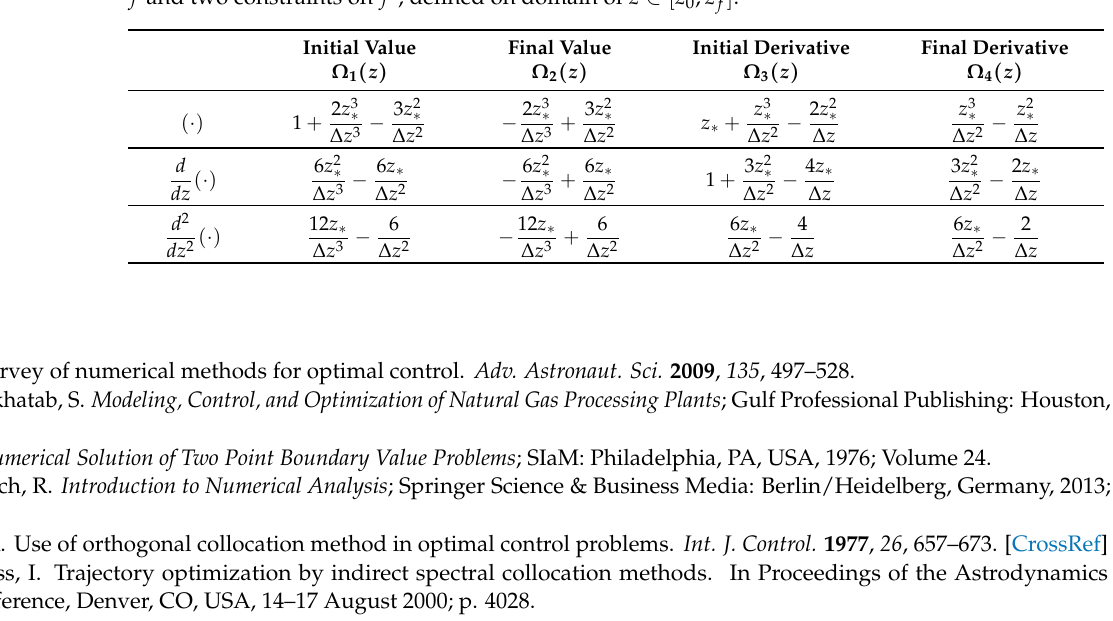
Table A6. Switching functions for a four constraints constrained expression, with two constraints on f and two constraints on f (cid:48) , defined on domain of z ∈ [ z 0 , z f ]